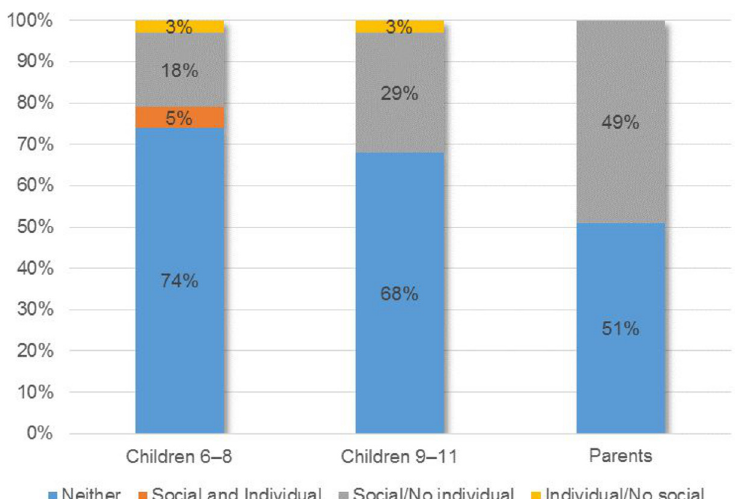
Fig 4. Frequencies of the composite models created on the closed-ended